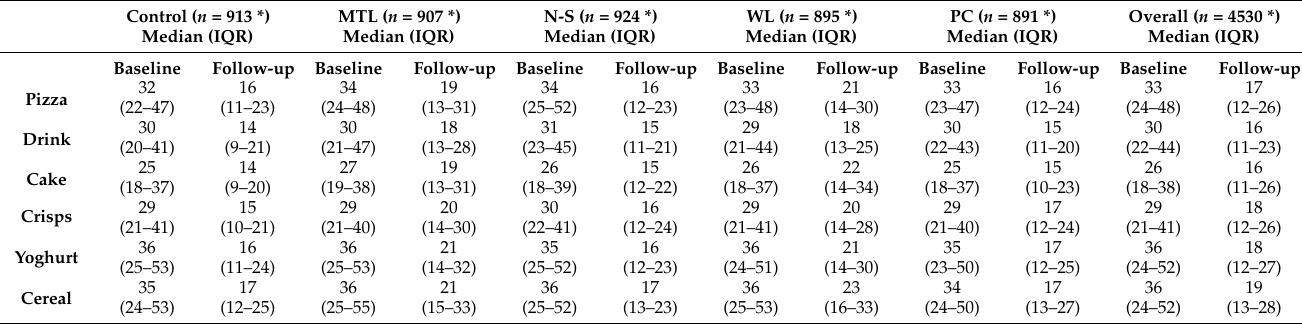
Table A1. Summary of baseline and follow-up ranking times (seconds) by product category, overall and experimental